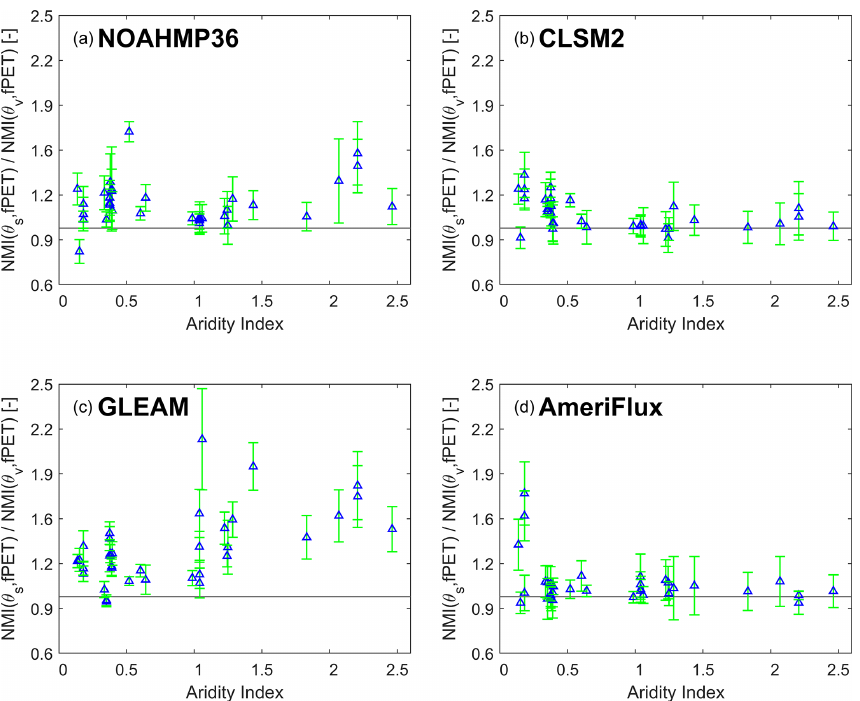
Figure 5. For (a) NOAHMP, (b) CLSM, (c) GLEAM and (d) AmeriFlux estimates, the ratio of NMI( θ s , fPET) and NMI( θ v , fPET) as a function of AI across all AmeriFlux